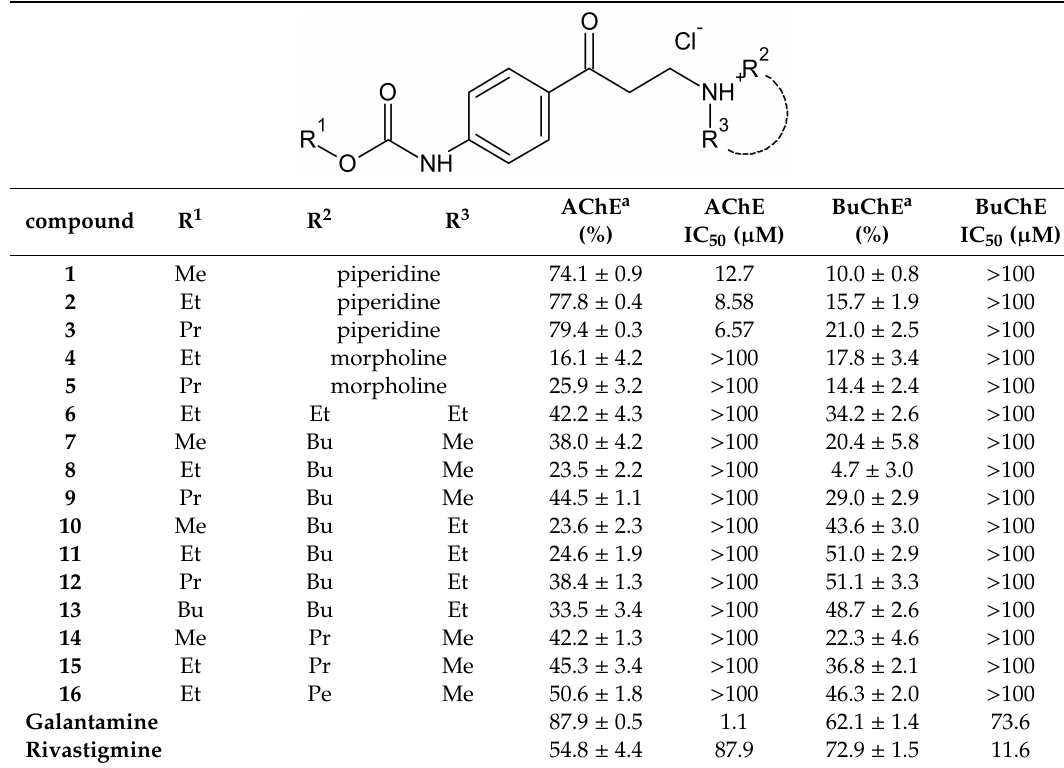
Table 1. Inhibitory activities of target compounds 1–16 against acetylcholinesterase (AChE)